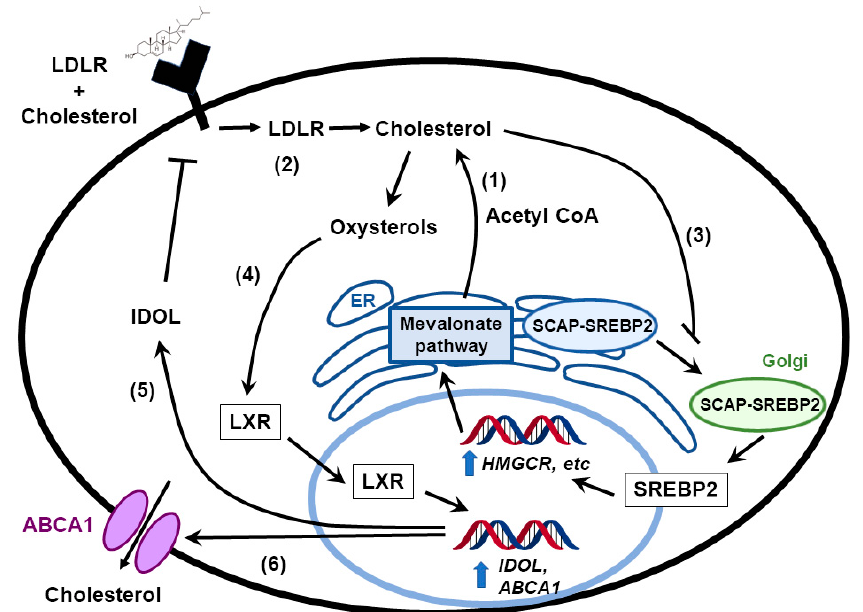
Figure 1. Cholesterol homeostasis in normal cells. Cells obtain cholesterol primarily through one of two mechanisms: (1) by synthesizing it de novo from acetyl CoA generated from glycolysis and (2) through exogenous uptake by low density lipoprotein receptors (LDLR). Cholesterol can negatively regulate its own levels through (3) the inhibition of proteolytic processing and nuclear import of sterol regulatory element binding proteins (SREBP2), leading to a decrease in activity in the mevalonate pathway or (4) through its conversion to oxysterols that activate liver X receptors (LXRs). LXRs lower cellular cholesterol levels by (5) inducing the transcription of the E3 ubiquitin ligase, IDOL , which ubiquitinates LDLR, and (6) by upregulating expression of the cholesterol efflux pump, ABCA1 . SCAP: SREBP cleavage-activating protein; ER: endoplasmic reticulum.